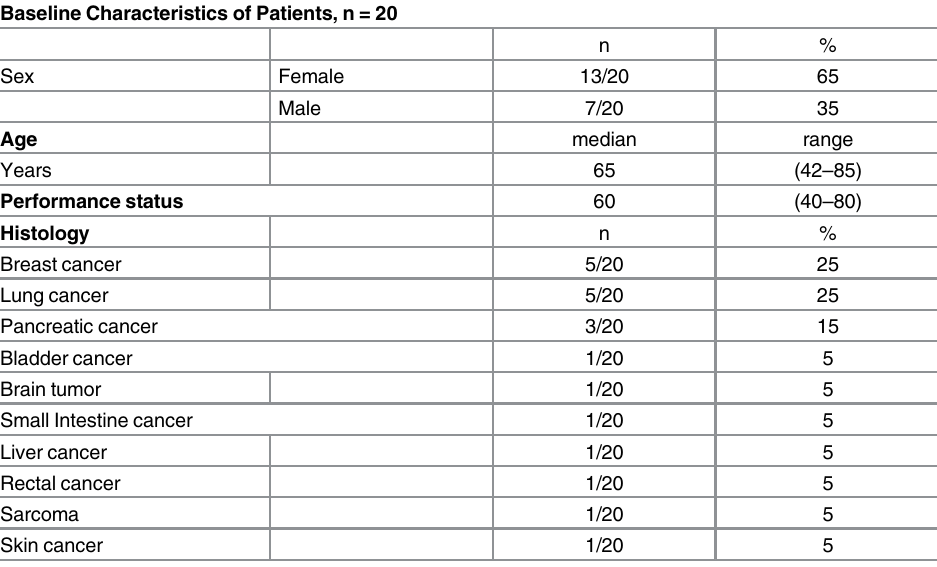
Table 3. Baseline Characteristics of